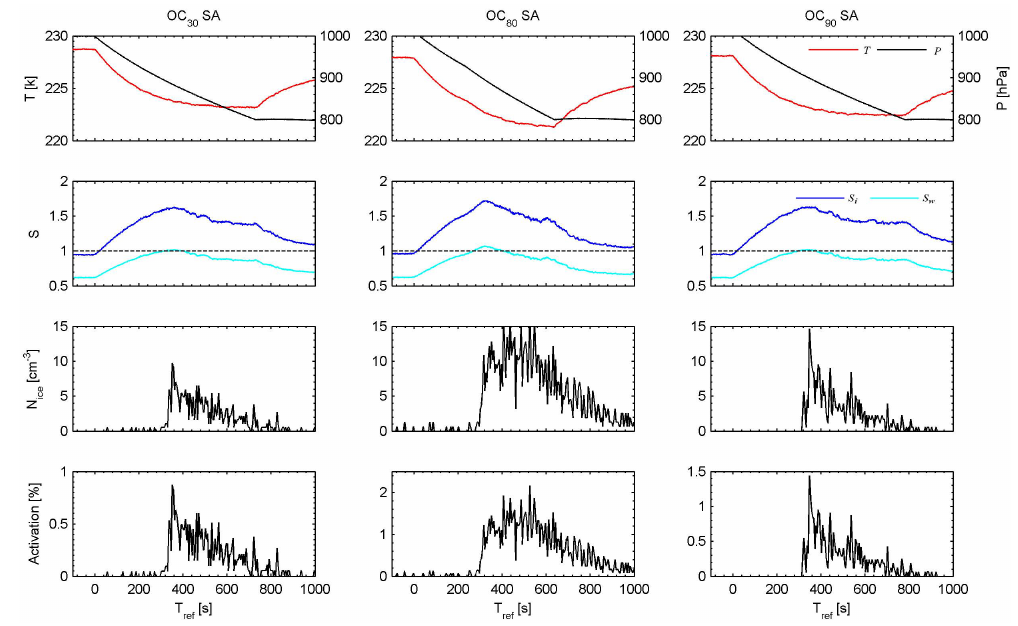
Fig. 8. Same as Fig. 6 but for mini-CAST OC 30 , OC 80 and OC 90 flame soot with sulphuric acid coating.